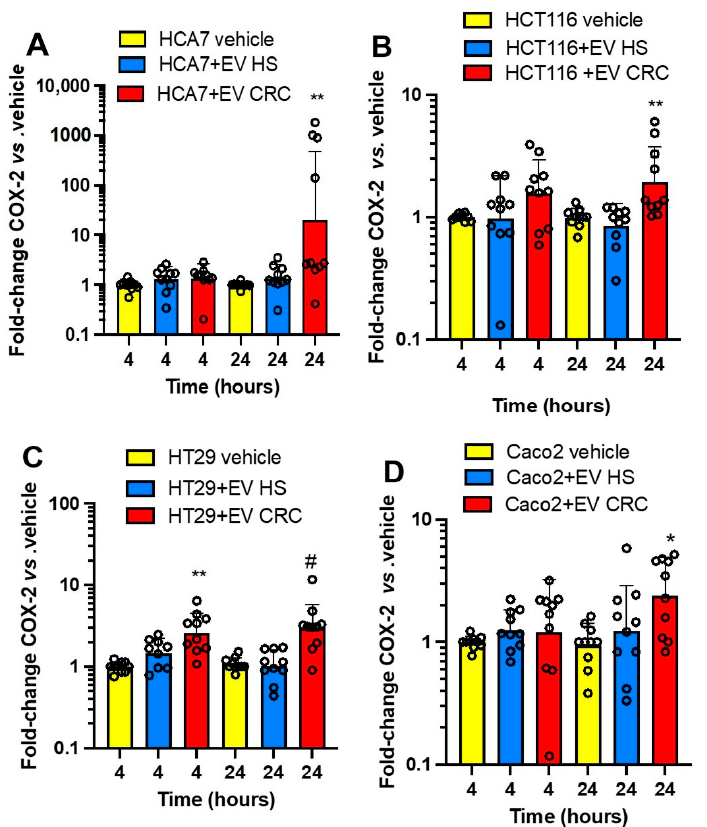
Figure 7. Effects of platelet-derived mEVs on the expression of COX-2 ( PTGS2 ) in cocultures with cancer cells. Cancer cells (0.5 × 10 6 ), ( A ) (HCA7 cells), ( B ) (HCT116 cells), ( C ) (HT29 cells), and ( D ) (Caco2 cells) were incubated for 4 and 24 h with EVs from CRC or HS individuals (100 μ g), and the gene expression of PTGS2 was evaluated by qPCR and normalized to that of GAPDH and reported as fold-change vs. the gene expression detected in the cocultures of mEV from HS with the cancer cells. The values were not normally distributed and were transformed to logarithms, and all values are shown as scatter dot plots with mean + SD, n = 10, and analyzed by one-way ANOVA followed by Tukey’s multiple comparisons test. ( A ) 24 h, ** p < 0.01 vs. vehicle and EV HS. ( B ) 24 h, ** p < 0.01 vs. vehicle and EV HS. ( C ) 4 h,** p < 0.01 vs. vehicle and EV HS; 24 h, # p < 0.01 vs. vehicle and EV HS. ( D ) 24 h, * p < 0.01 vs. vehicle and EV HC.